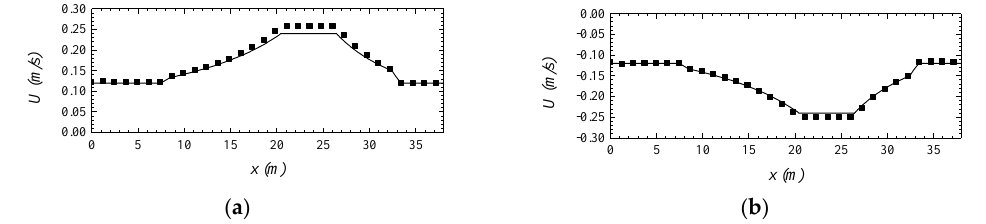
Figure 15. Velocity distribution of MIKE 21 BW model ( ■ ) and theoretical value (solid line) in sub- merged dike topography: ( a ) downstream, ( b ) counter current.